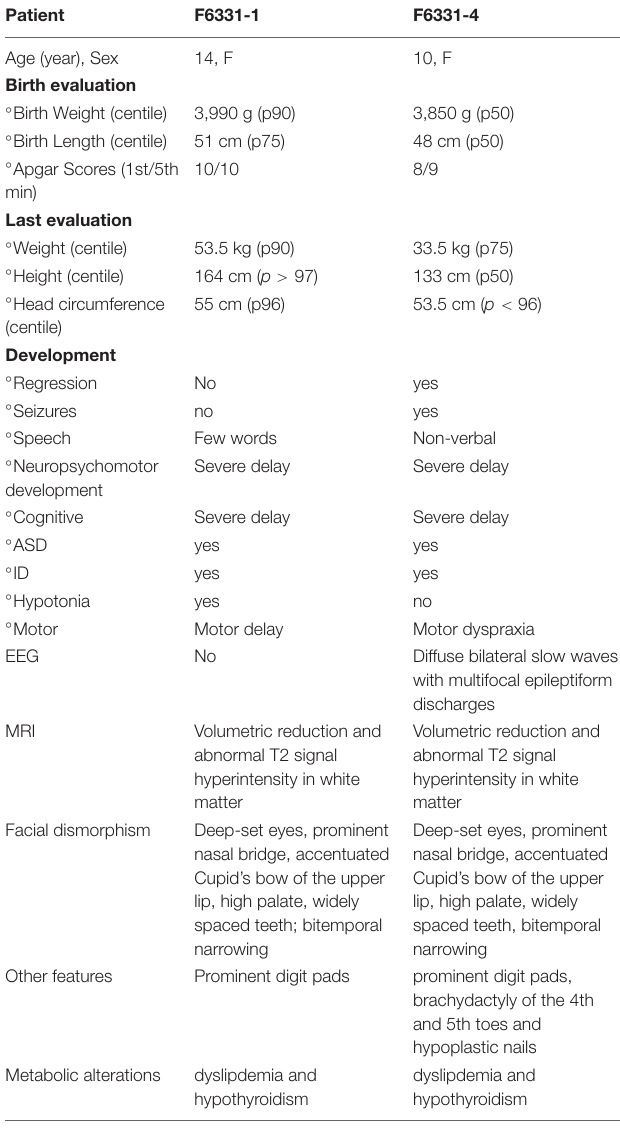
TABLE 1 | Clinical characteristics of two patients with IHPRF3.